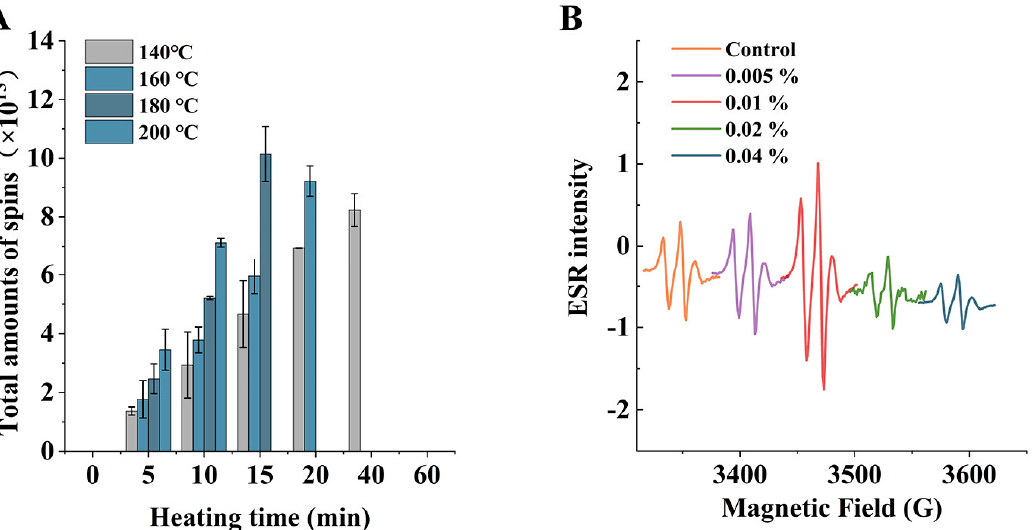
Figure 4. Total amounts of spin under different heating temperatures and times ( A ); ESR spectrum of different catechin addition at 160 °C for 20 min ( B ).